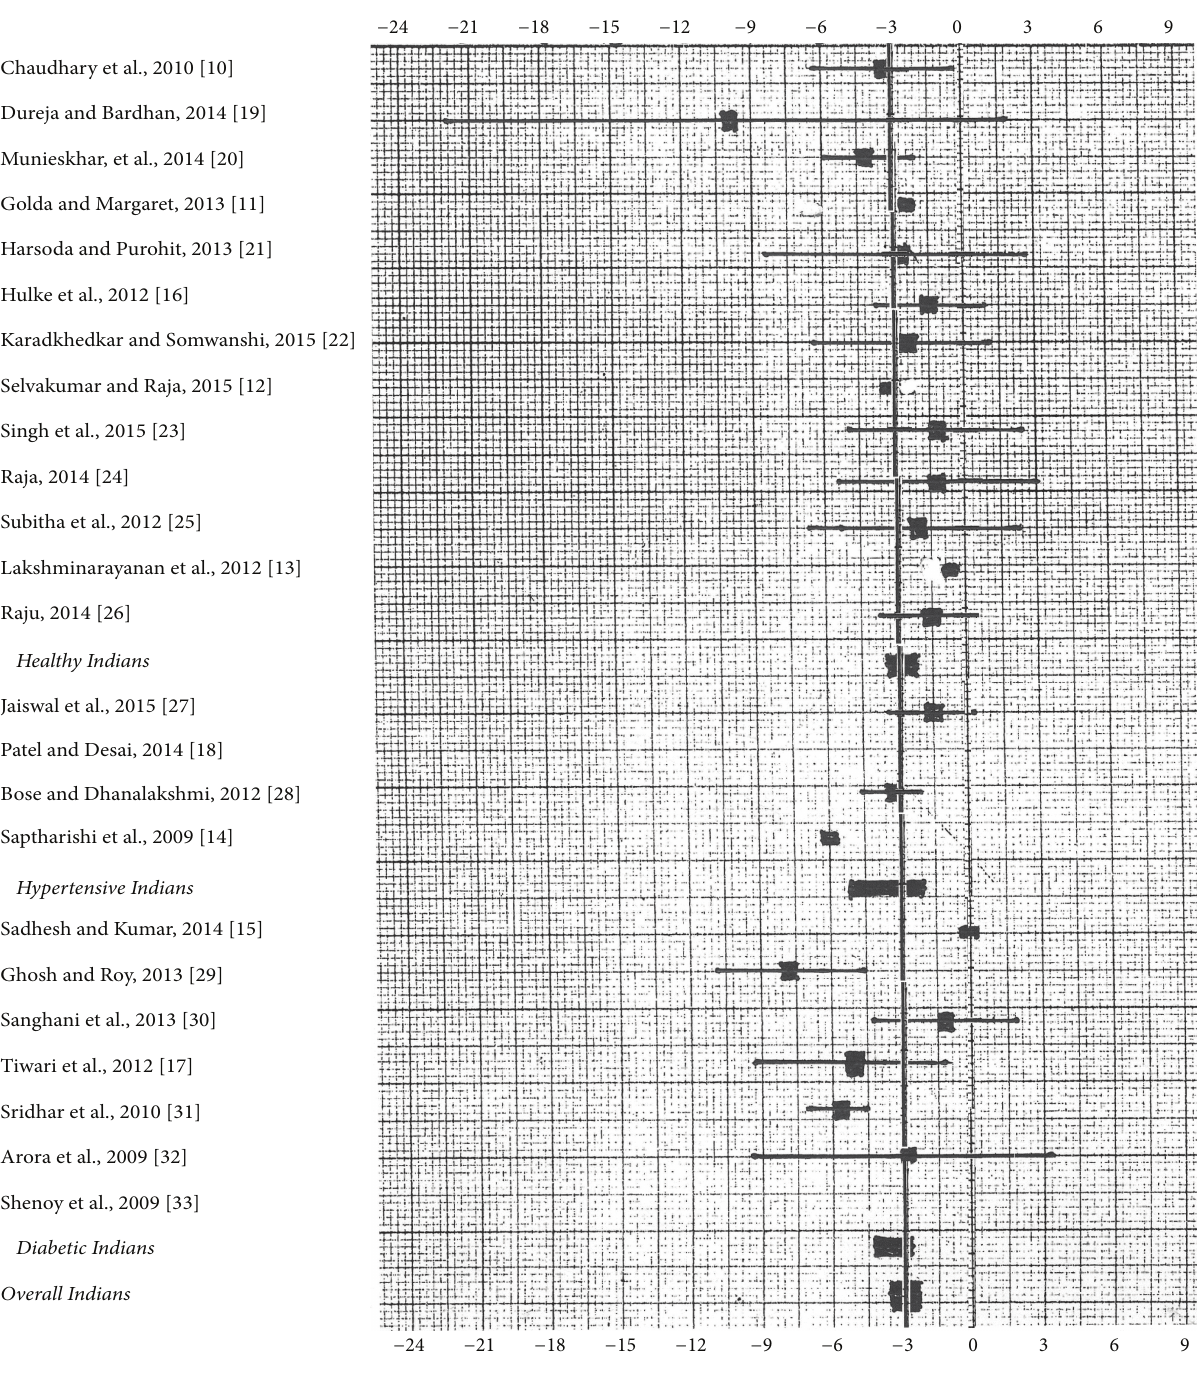
would result in estimated 12% increased risk for CHD and 24% increased risk for stroke